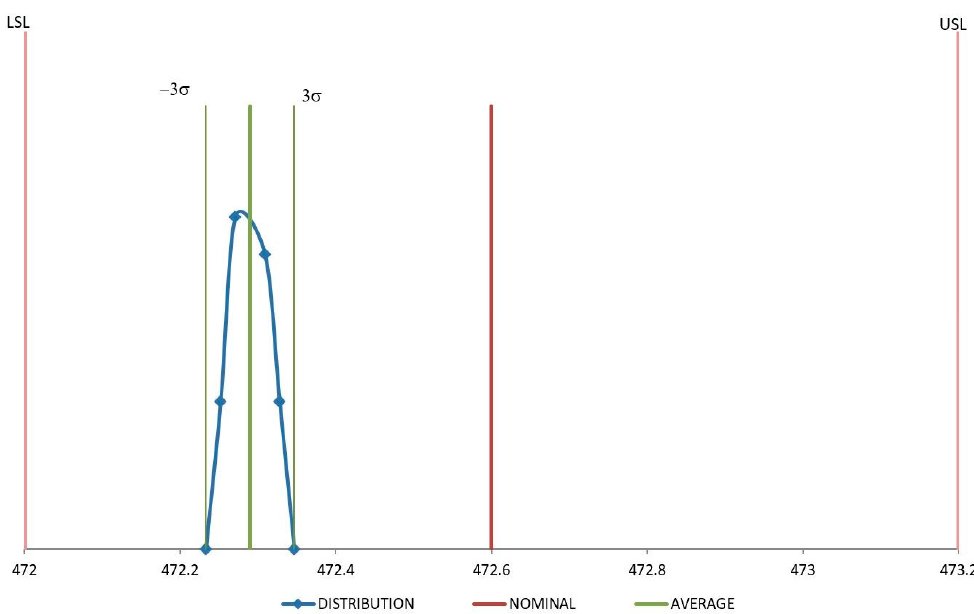
Figure 9. Distribution for D4 (mm) with raw material.